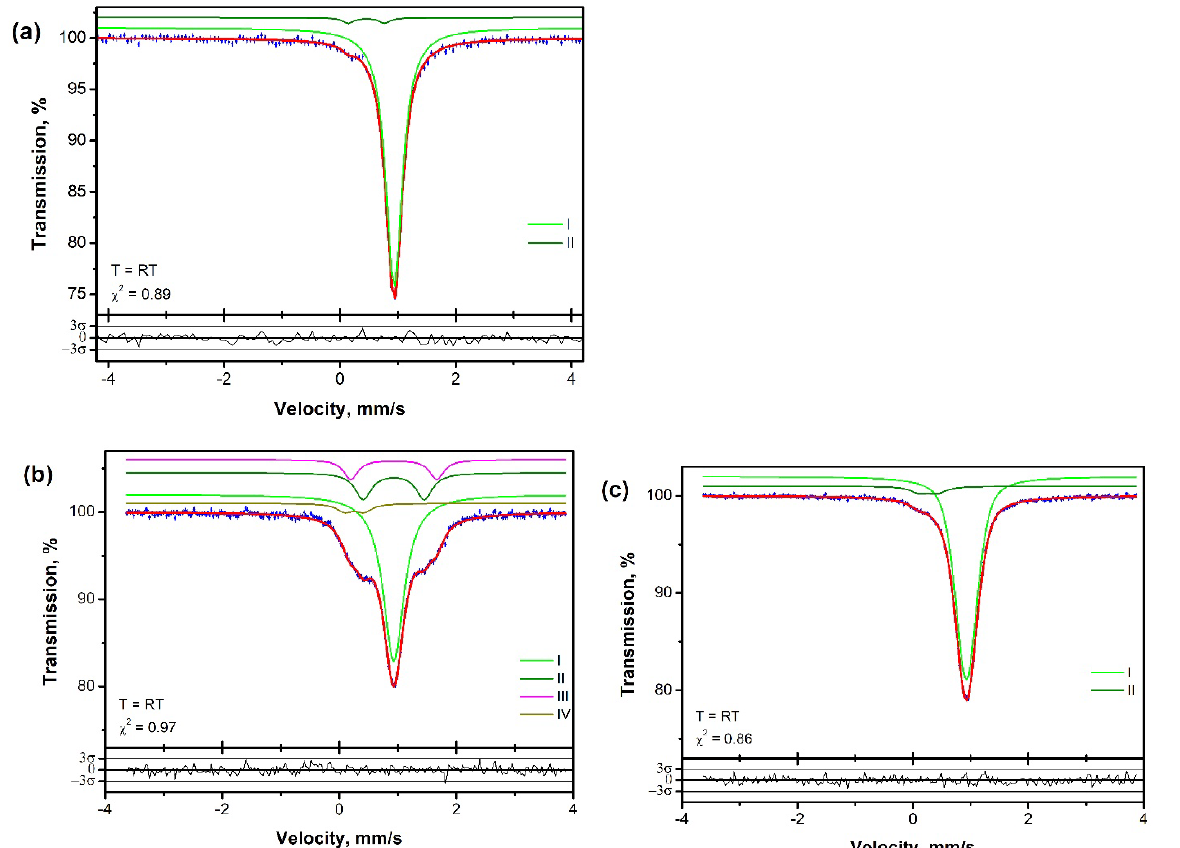
Figure 4. Mössbauer spectra at room temperature of ( a ) polycrystalline FeCr 2 O 4 powder used for the crystal growth, ( b ) as grown single crystal FeCr 2 O 4 , and ( c ) after the post-annealing (see text).